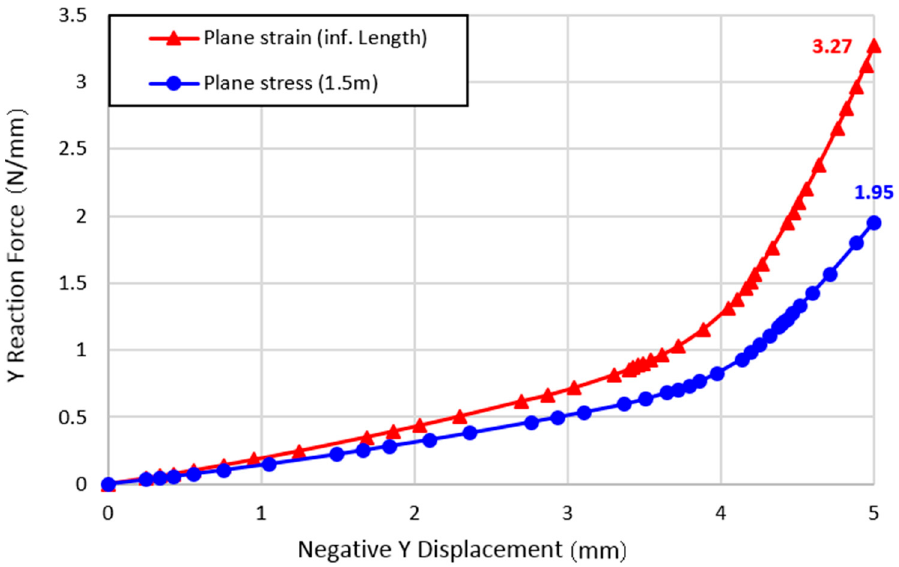
Figure 10. Y reaction force vs. Negative Y displacement for the simulations. Buildings 2018 , 8 , x FOR PEER REVIEW